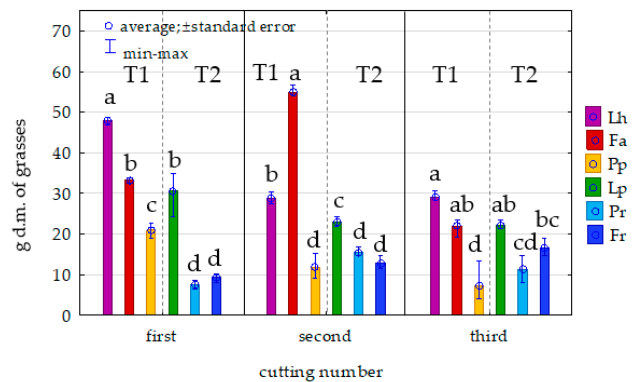
Figure 1. The yield of grasses in g dry matter (d.m.) per pot. T1—fodder grasses; T2—lawn